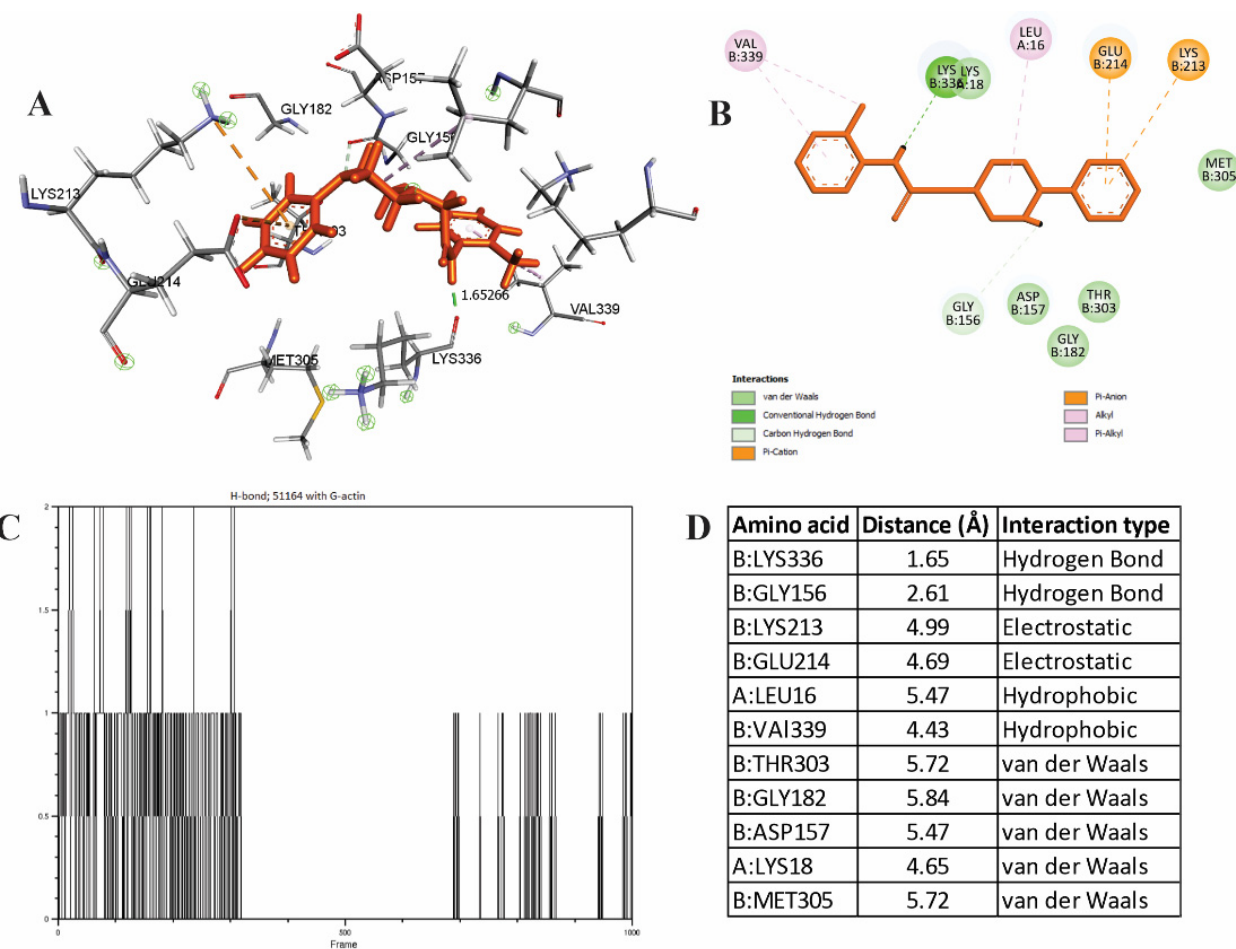
Figure 5. Spatial properties of 51164–G-actin complexation. ( A ) Spatial arrangement of 51164 in the ATP binding site. ( B ) Conformational map of the complexation of 51164 with G-actin. ( C ) The number of hydrogen bonds during complexation, ( D ) The list of amino acids involved in the interaction.